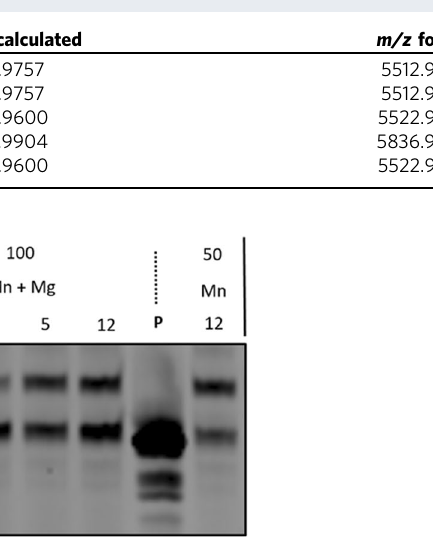
Fig. 5 Evaluation of modi fi ed nucleotide 5 under TdT-mediated reactions. Gel image (PAGE 20%) shows the results of the TdT-mediated extension reactions with 3 ′ -phos-dTTP 5 and 5 ′ -FAM-labeled primer P2 (20 pmoles). Reaction mixtures contained TdT (10 U), triphosphate at 100 or 50 µ M concentration, magnesium and/or manganese cofactors at 1 mM concentration, and were incubated at 37 °C for given reaction times. P represents unreacted, 5 ′ -FAM-labeled